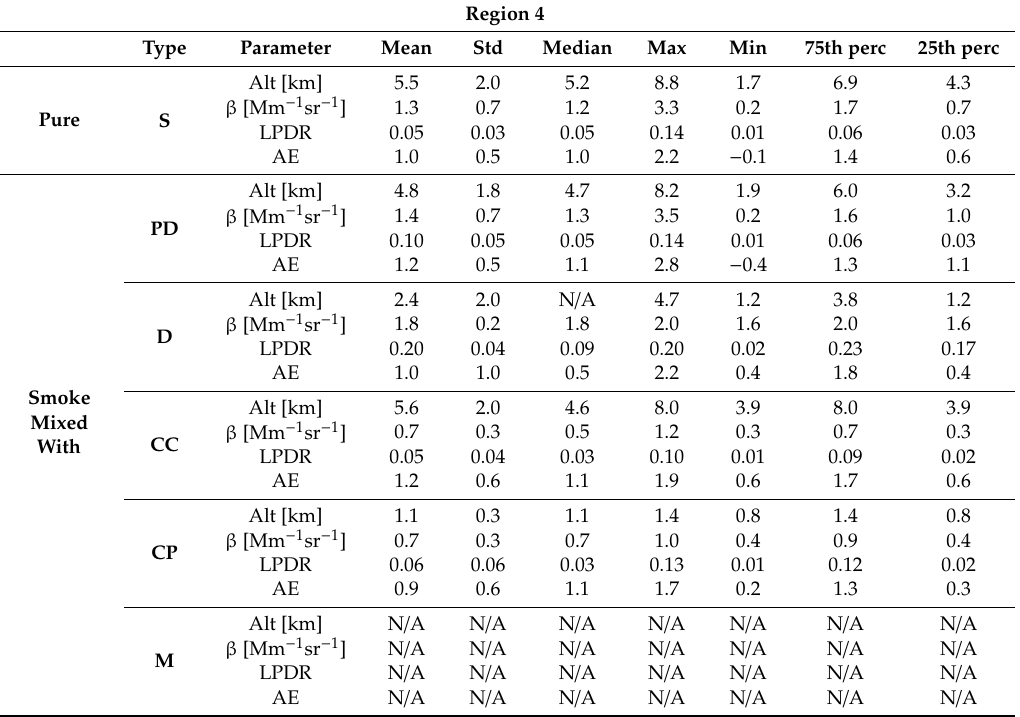
Table A4. Descriptive Statistics for di ff erent aerosol types for Region 4 (R4): mean, standard deviation (std), median, maximum value (max), minimum value (min), 75th and 25th percentile for all